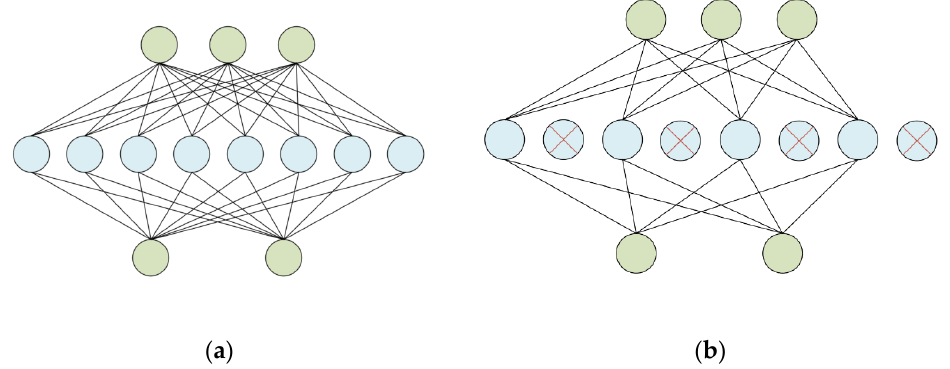
Figure 3. Comparison of the standard network and dropout network: ( a ) standard network; ( b ) dropout network with dropout rate of 0.5.